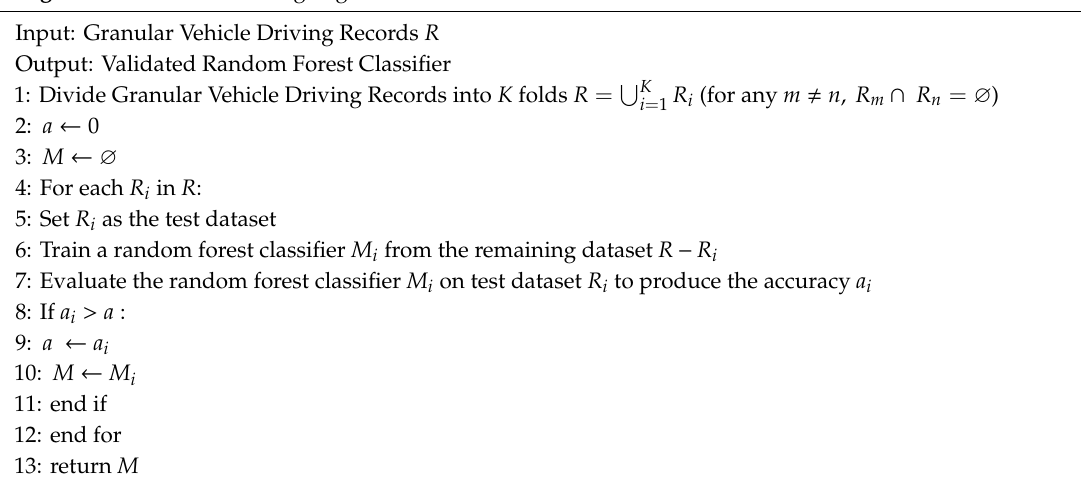
Algorithm 1: Model Training Algorithm Based on K-Fold